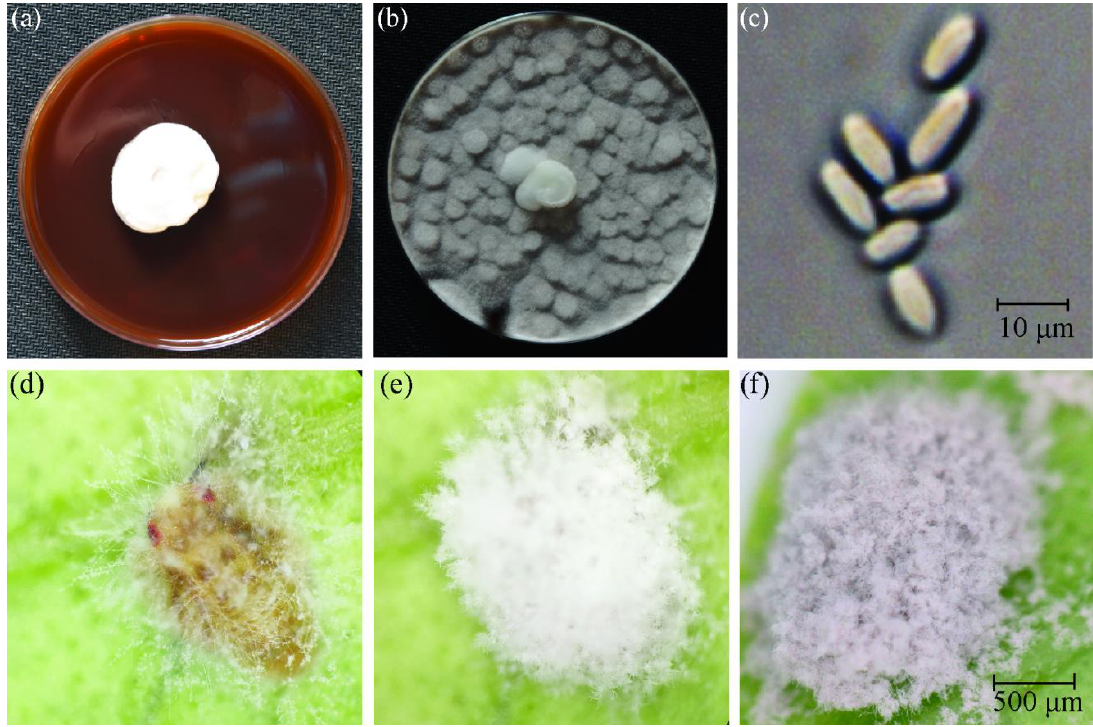
Figure 1. Morphology characteristics of the isolate on SDAY medium and 5th instar nymph of D. citri. ( a ) The upper side of the colony on SDAY on 5th day at 25 °C; ( b ) the upper side of the mature colony on SDAY on the 15th day at 25 °C; ( c ) mature conidia; ( d ) 5th instar nymph of D. citri inoculated with 1 × 10 7 conidia mL −1 on 3rd day after inoculation; ( e ) 5th instar nymph of D. citri inoculated with 1 × 10 7 conidia mL −1 on 5th day after inoculation; ( f ) 5th instar nymph of D. citri inoculated with 1 × 10 7 conidia mL −1 on 9th day after inoculation.